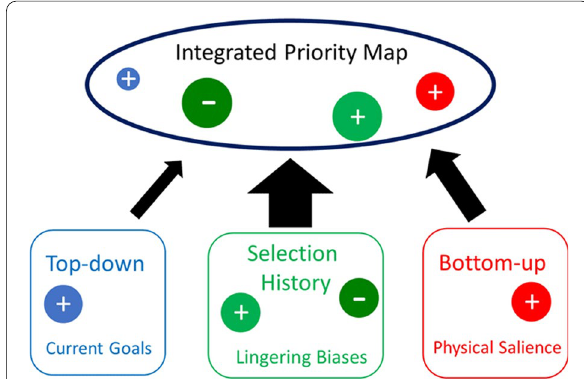
Fig. 1 A schematic representation of how a priority map that integrates three sources of selection biases: the observer’s current selection goals, selection history, and the physical salience of the items competing for attention (adapted from Theeuwes 2019). The smaller blue plus sign as part of the priority map indicates that the role of top-down selection is rather limited (Theeuwes 2018; but see Wolfe